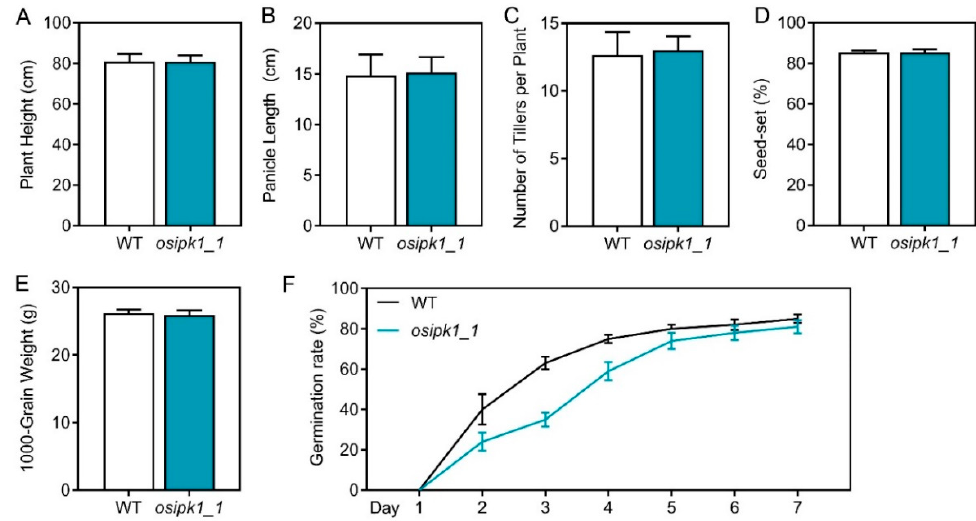
Figure 2. Agronomic traits ( A – E ) and seed germination rate ( F ) of Xidao #1 (wild type, WT) and its OsIPK1 mutant line osipk1_1 . Twenty single plants were investigated for WT and osipk1 _1. Error bars represent standard error. ( F ) The germination rate was recorded from 1 to 7 days after soaking, and three replicates in each group.